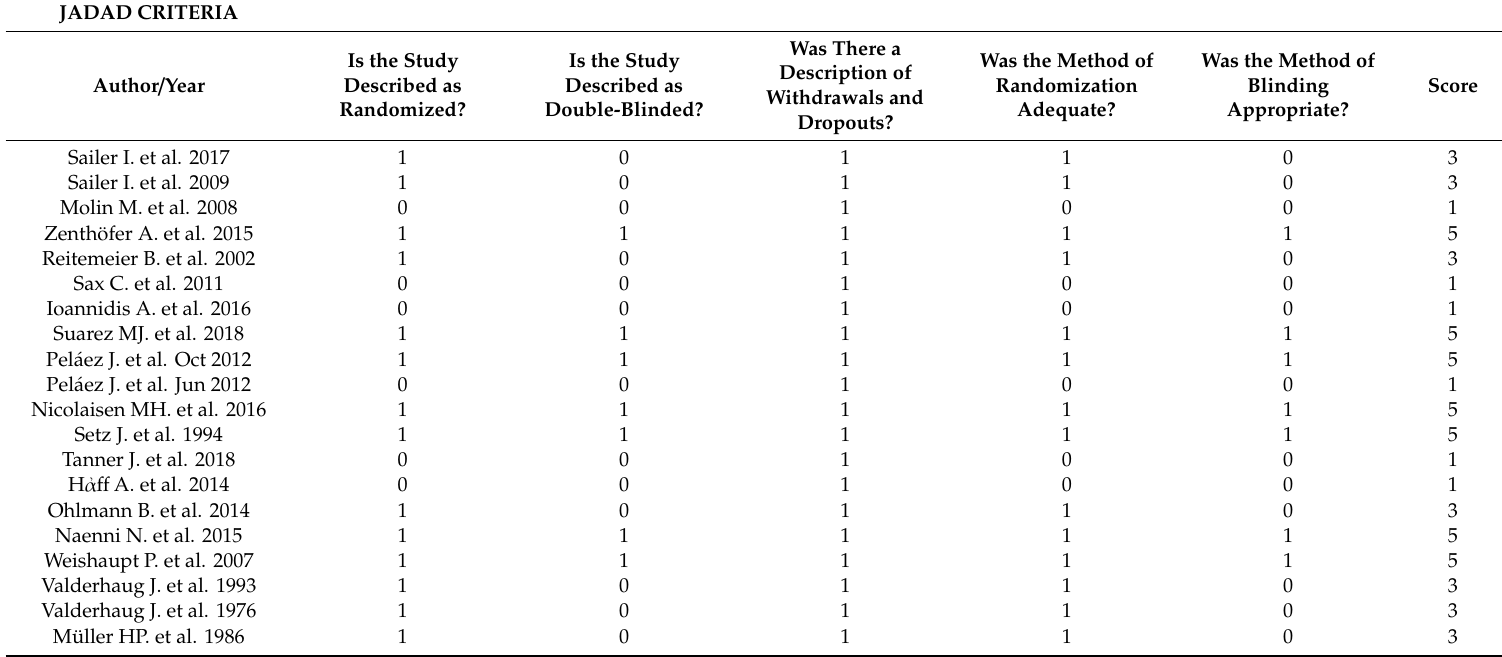
Table 1. Assessment of methodological quality according to the Jadad